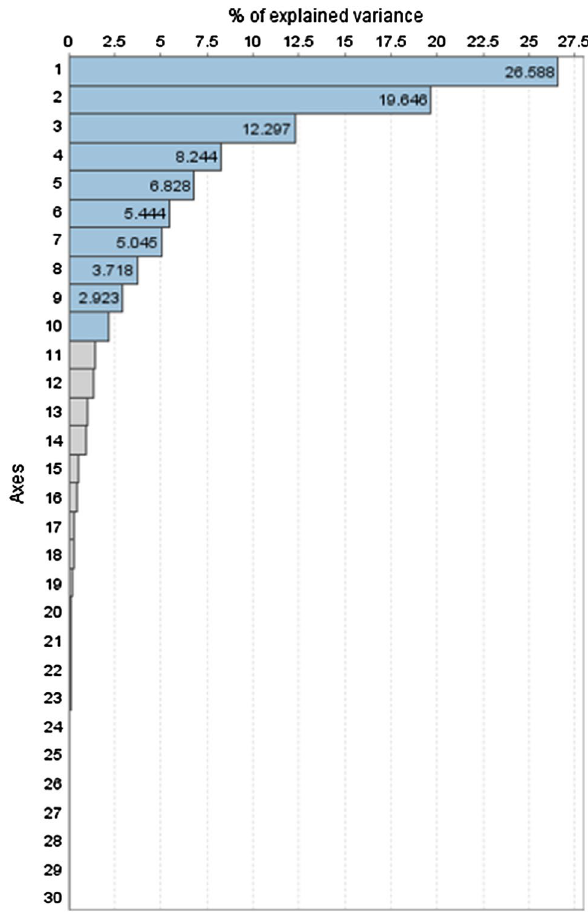
Figure 1. Principal component analysis. Ten principal components accounted for 92.7% of the variation as assessed by